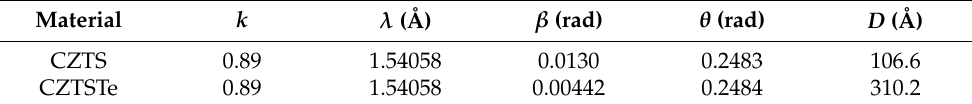
Table 1. Crystal